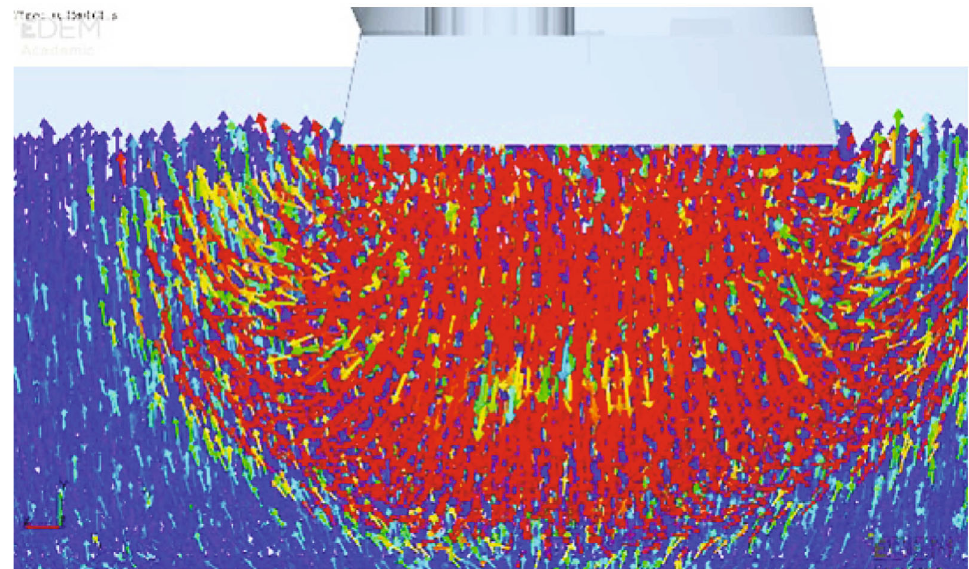
Figure 20: Landing impact model and lunar soil impact